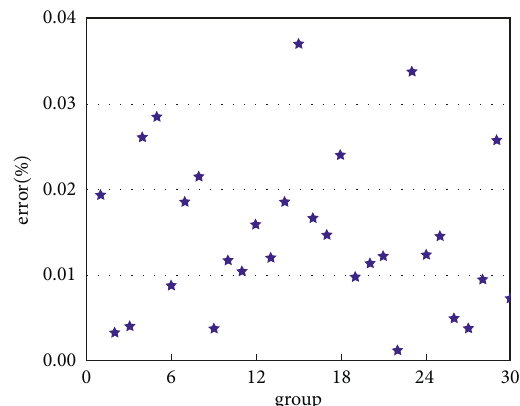
Figure 7: The prediction error distribution for rap